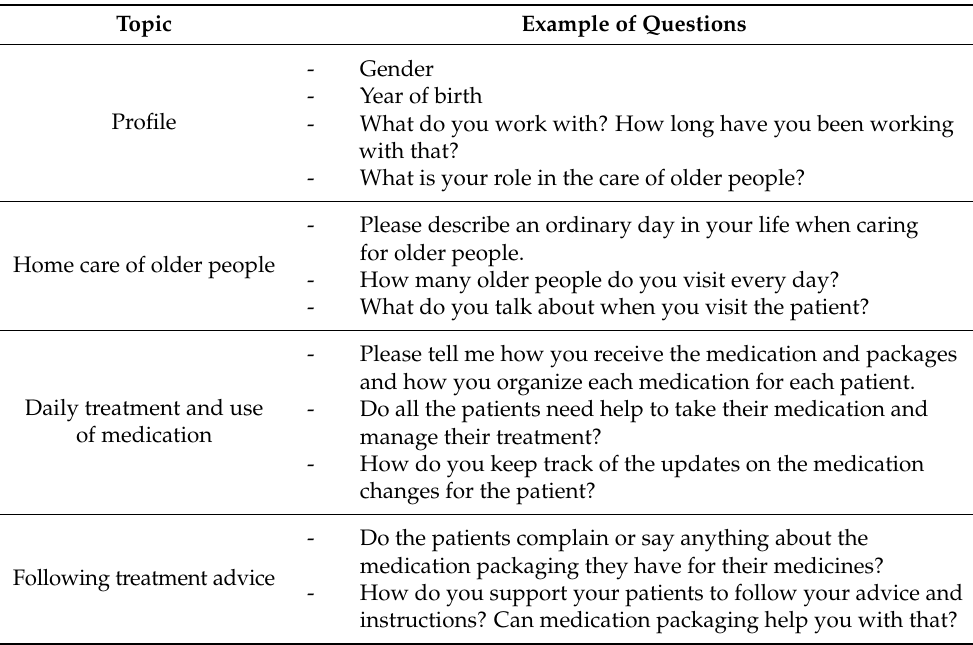
Table 1. Main topics of the interview